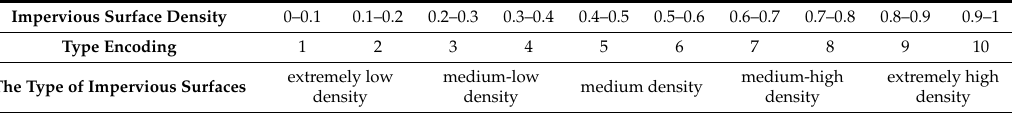
Table 2. Classification of the density type of impervious